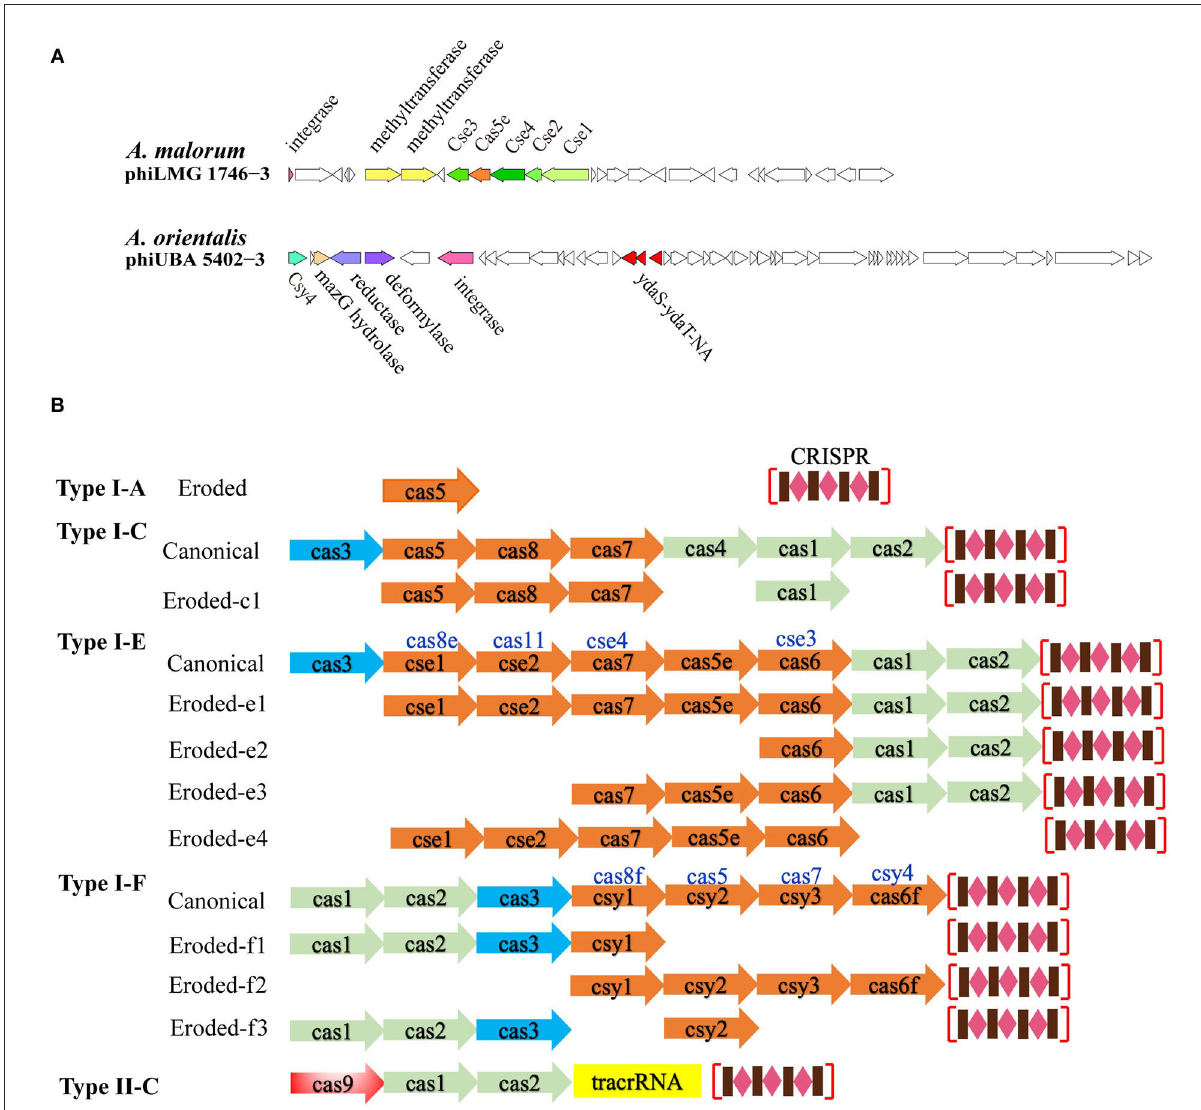
FIGURE6 Architecture of prophage genomic loci for the subtypes of CRISPR-Cas systems. (A) Two unique genomes of the Acetobacter -specific prophages harbored the eroded type I-E and I-F CRISPR-Cas loci. (B) Diagrams of the intact or incomplete CRISPR-Cas loci representatives existed on Acetobacter genomes. Genes encoding the adaption, effector, and target cleavage module are colored in green, orange, and blue,